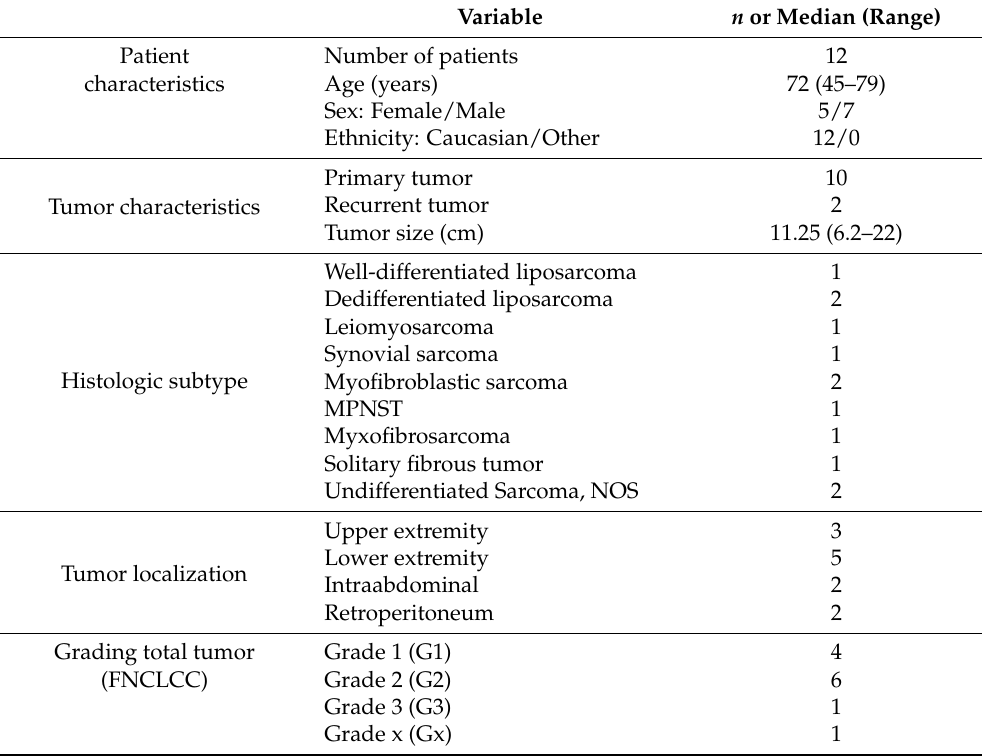
Table 1. Patient and tumor